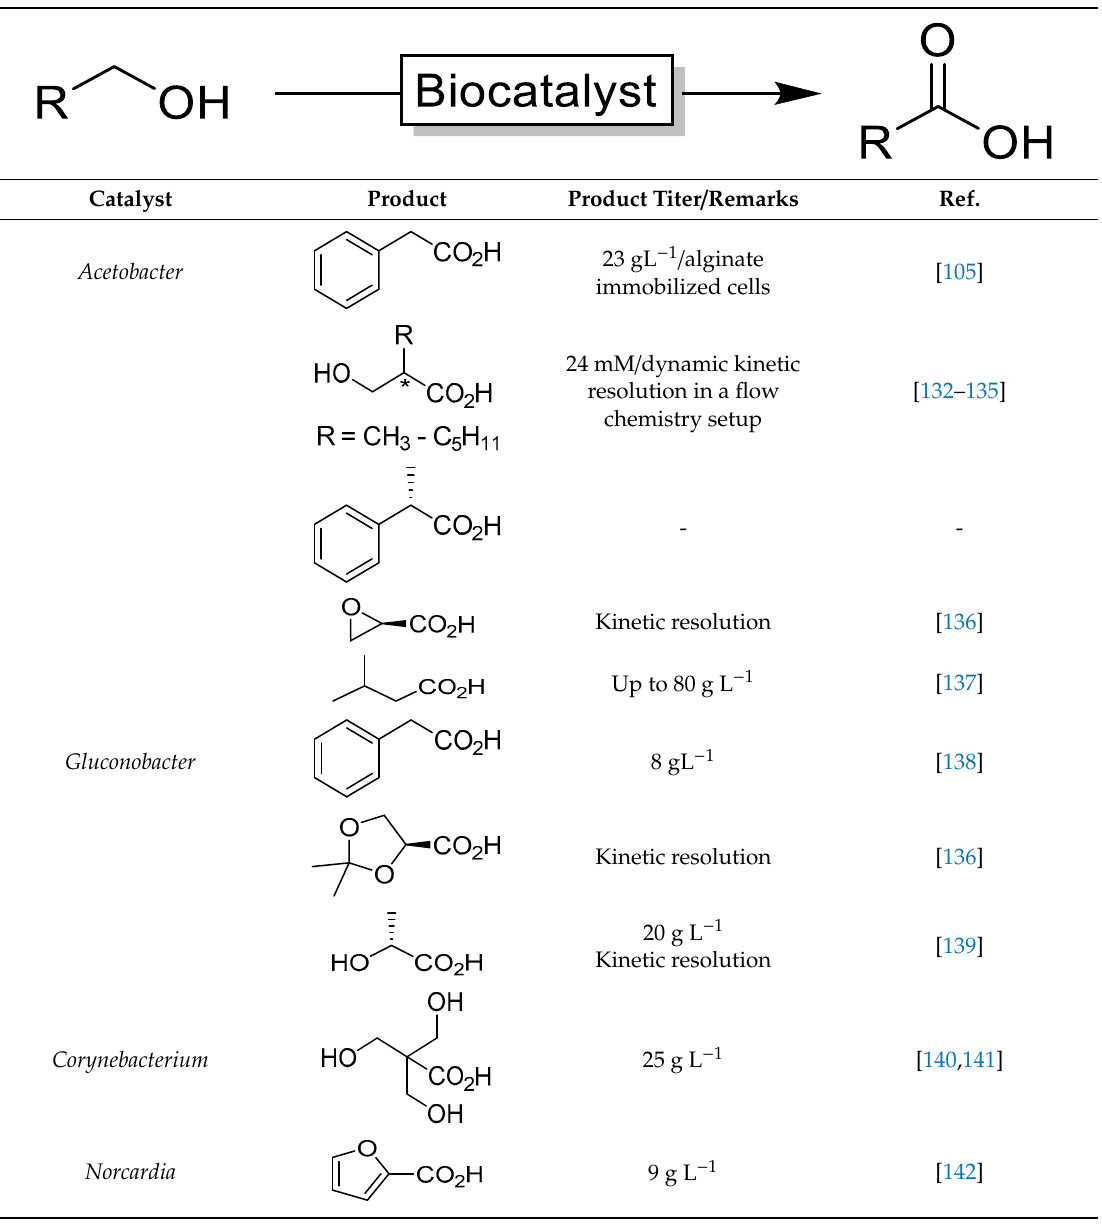
Table 3 . Selection of microbial through oxidations of primary alcohols.